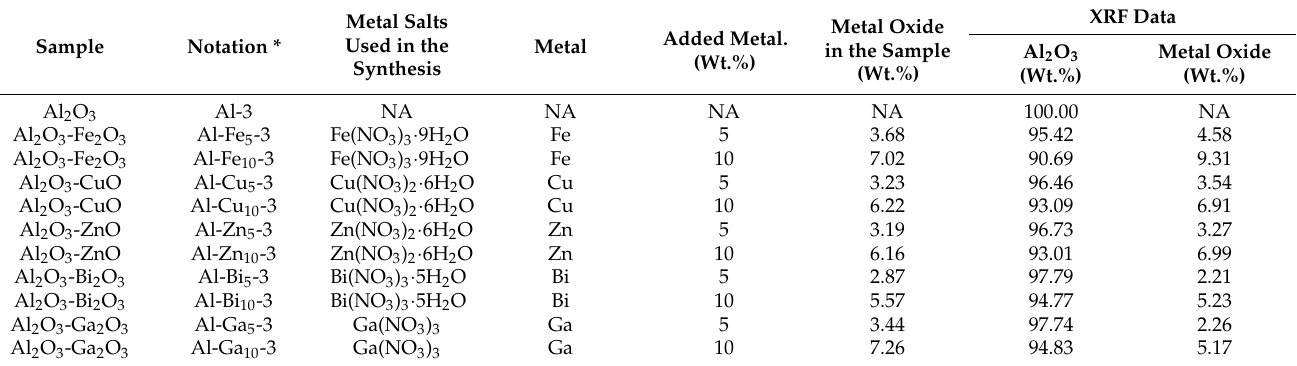
Figure 1. Schematic representation of the synthesis of γ -alumina with incorporated metal oxides. Table 1. Sample notations and metal oxide percentages predicted and obtained by XRF analysis.